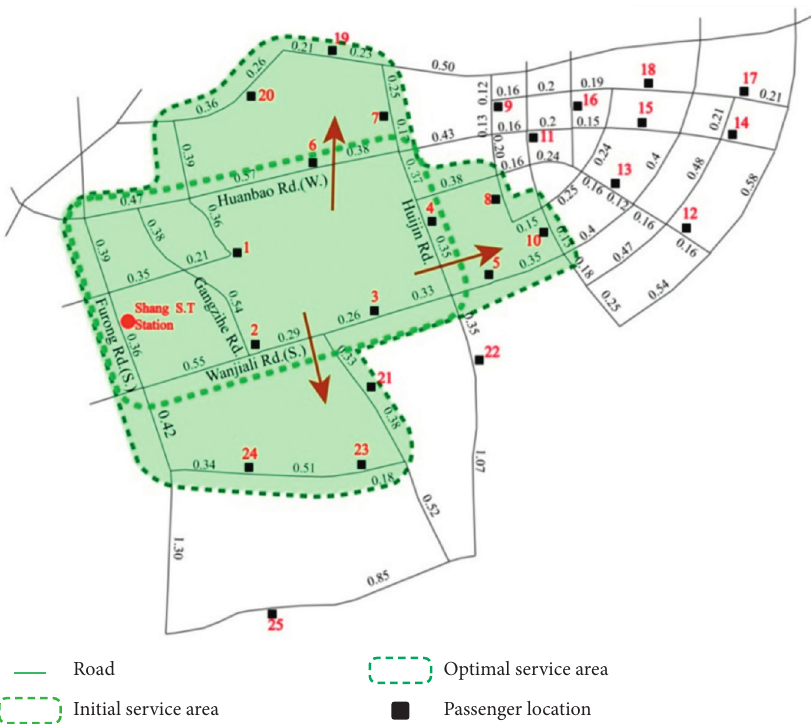
Figure 7: Service area optimization